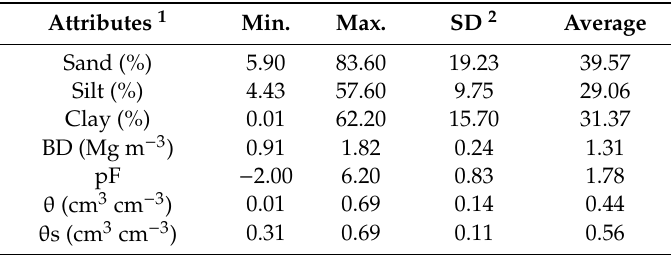
Table 1. Characteristics of the soils used in this